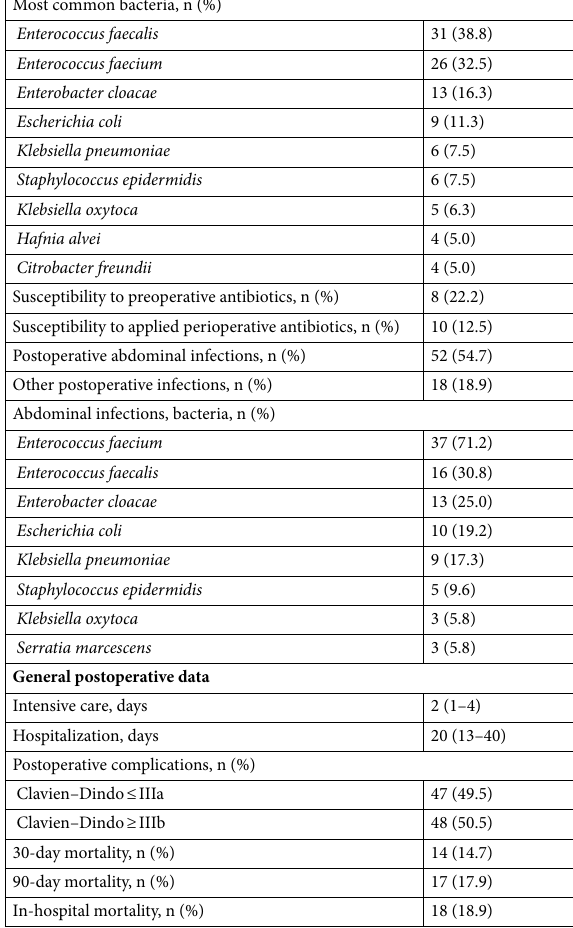
Table 1. Clinical and microbiological characteristics (n = 95). Data presented as median and interquartile range if not noted otherwise. ALT alanine aminotransferase, ASA American society of anesthesiologists classification, AST aspartate aminotransferase, BMI body mass index, CRP c-reactive protein, EBD endoscopic biliary drainage, FFP fresh frozen plasma, GGT gamma glutamyltransferase, INR international normalized ratio, PBD percutaneous biliary drainage, PVE portal vein